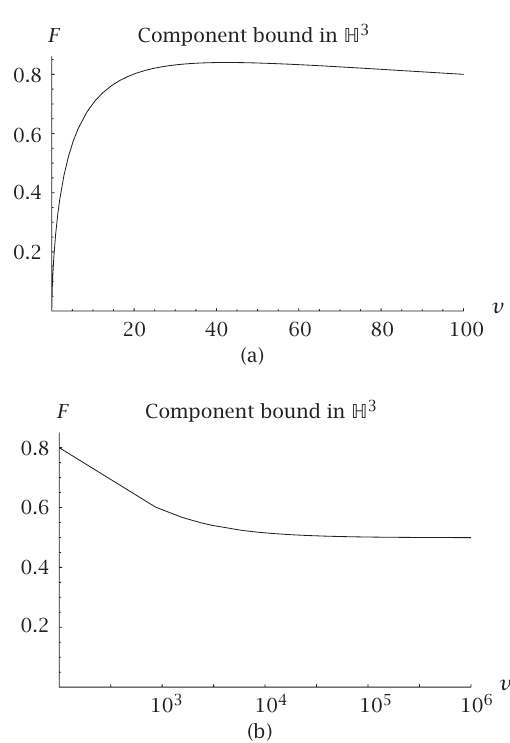
∈ [ 0 , 10 6 ] suggest that F Figure 5.2 . Plots of F h (v) for v h (v) is positive in this interval, and thus each region of a double bubble enclosing equal volumes has one component. (Graph (a) plots F h (v) for v ∈ [ 0 , 100 ] , and graph (b) plots F h (v) for v ∈ [ 100 , 10 6 ] on a logarithmic